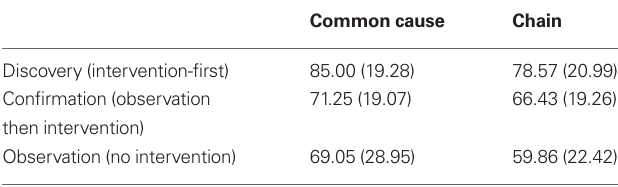
Table 2 | Proportion of causal structure questions answered correctly on common cause and chain model across the learning conditions.